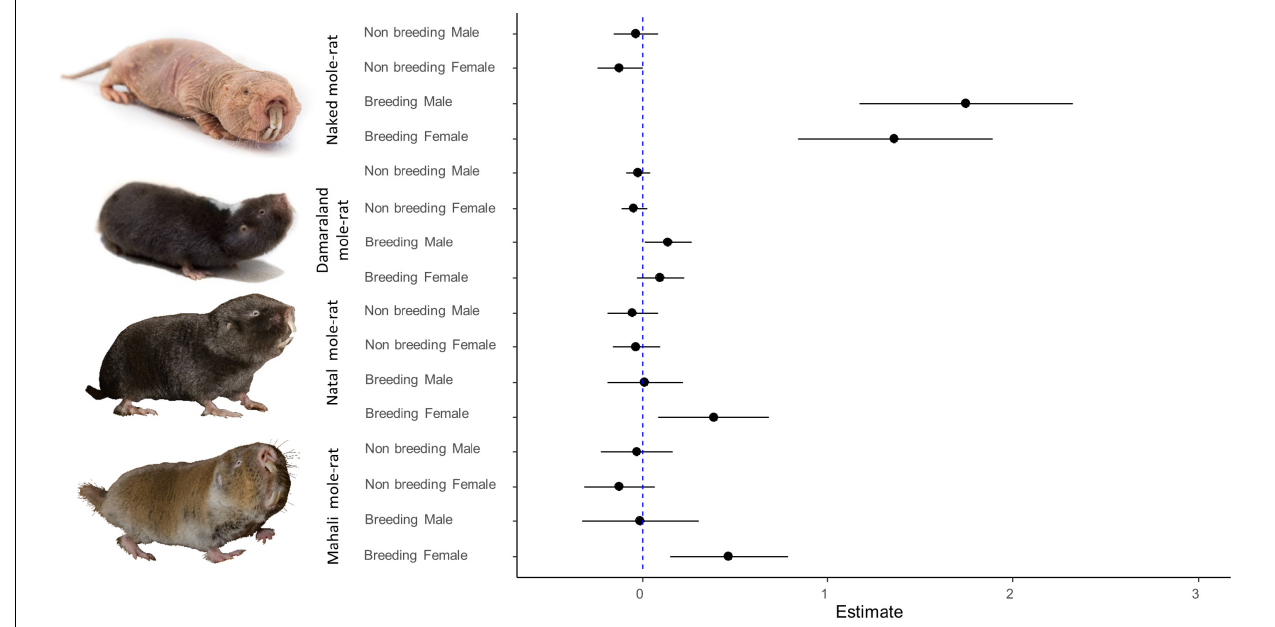
FIGURE 1 | Effect size estimates for breeder status and sex on capture order across naked mole-rats, Damaraland mole-rats, Natal mole-rats, and Mahali mole-rats. Error bars represent 95% confidence intervals. Photographs by Kyle T. Finn and Yannick